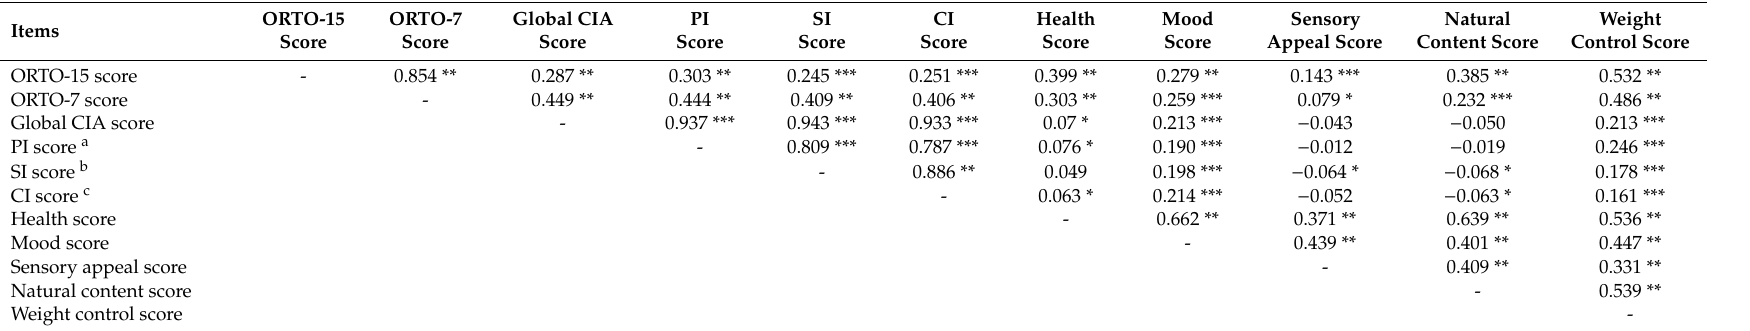
Table 4. Pearson’s correlations between ORTO-15 and ORTO-7 scores, psychosocial impairment, and motives of food